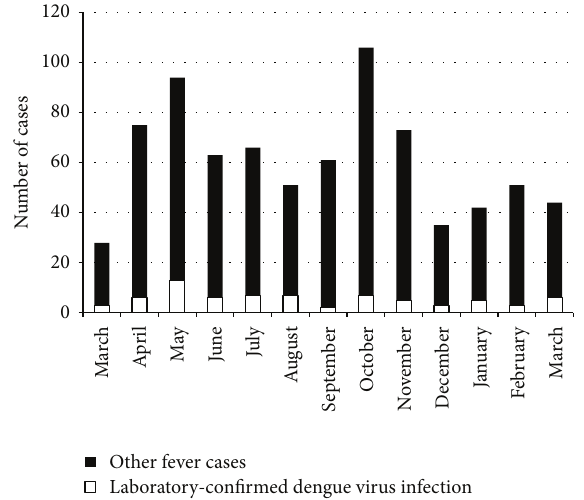
Figure 1: Number of febrile patients included in the study and dengue virus diagnostic results, by month, Medellin, Colombia, March 2008-2009 ( 𝑛 = 781